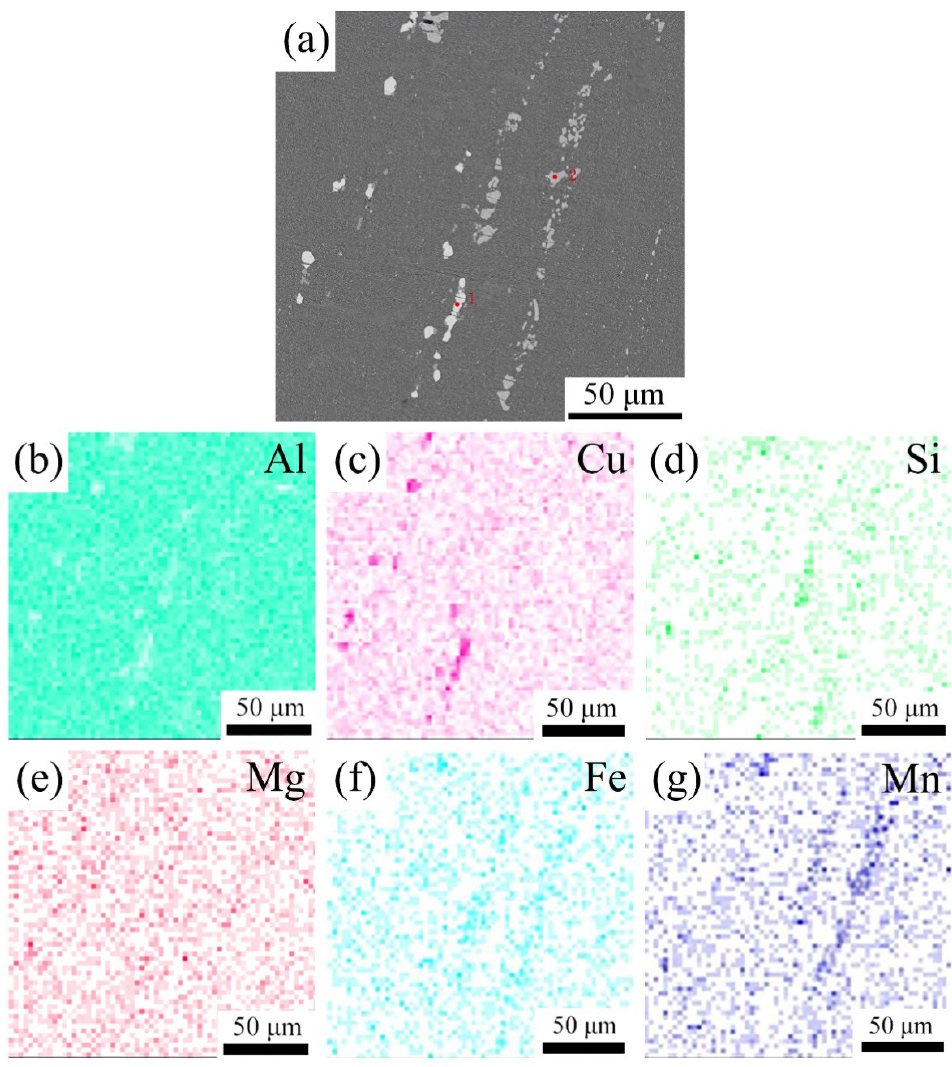
Figure 4. ( a ) Backscattered electrons (BSE) micrograph, ( b – g ) mapping of Al, Cu, Si, Mg, Fe and Mn. (2D distribution of elements determined using